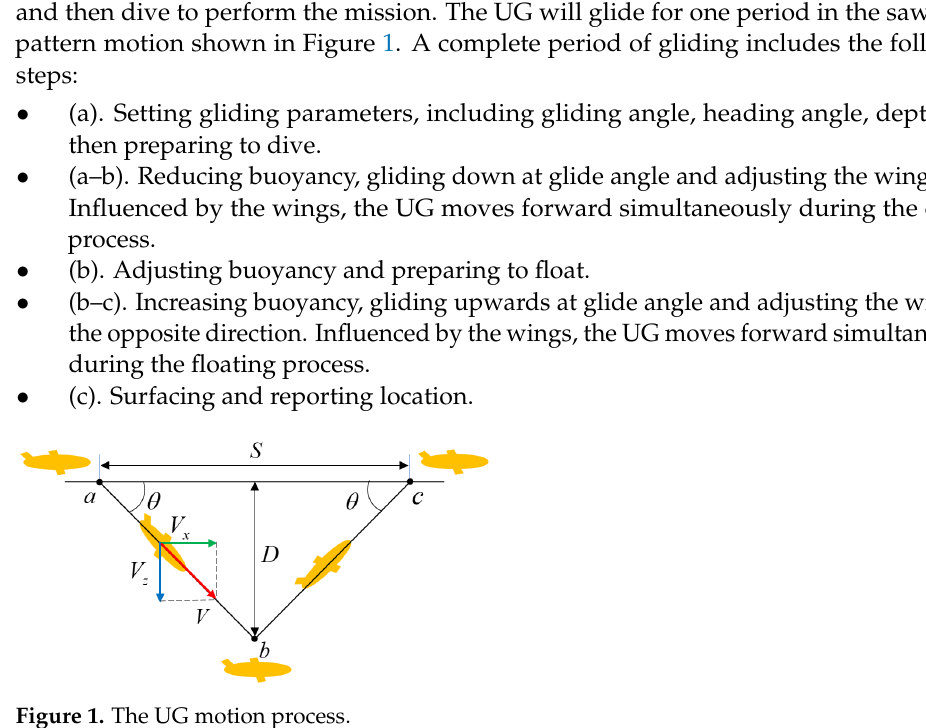
Figure 1. The UG motion process.